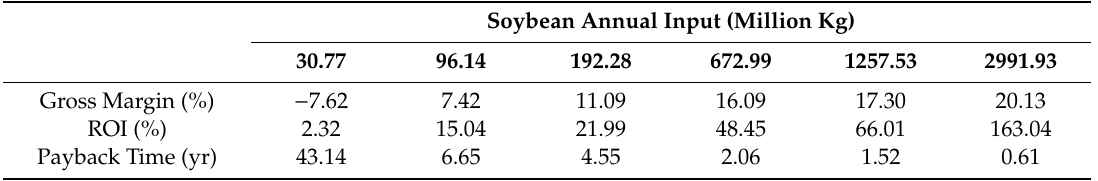
Table 7. Gross margin, ROI, and payback time of various soybean oil production